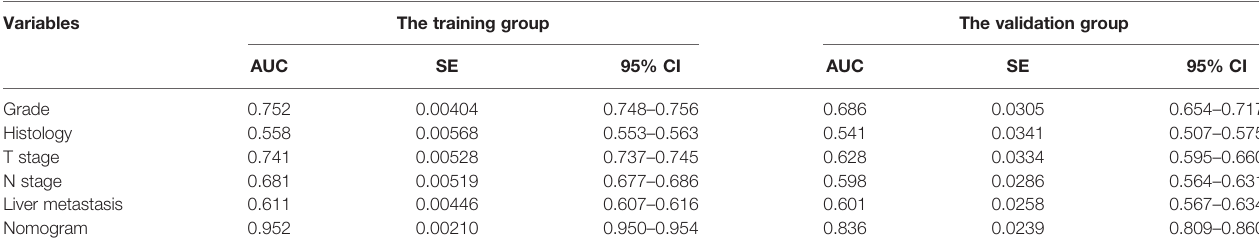
TABLE 4 | The area under curve (AUC) for predicting BMs.